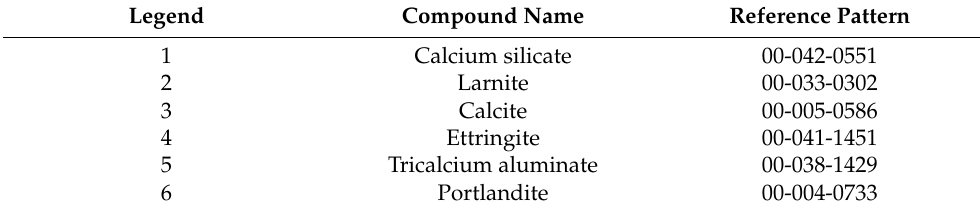
Table 6. Mineralogical compounds detected by using X’Pert High Score software.